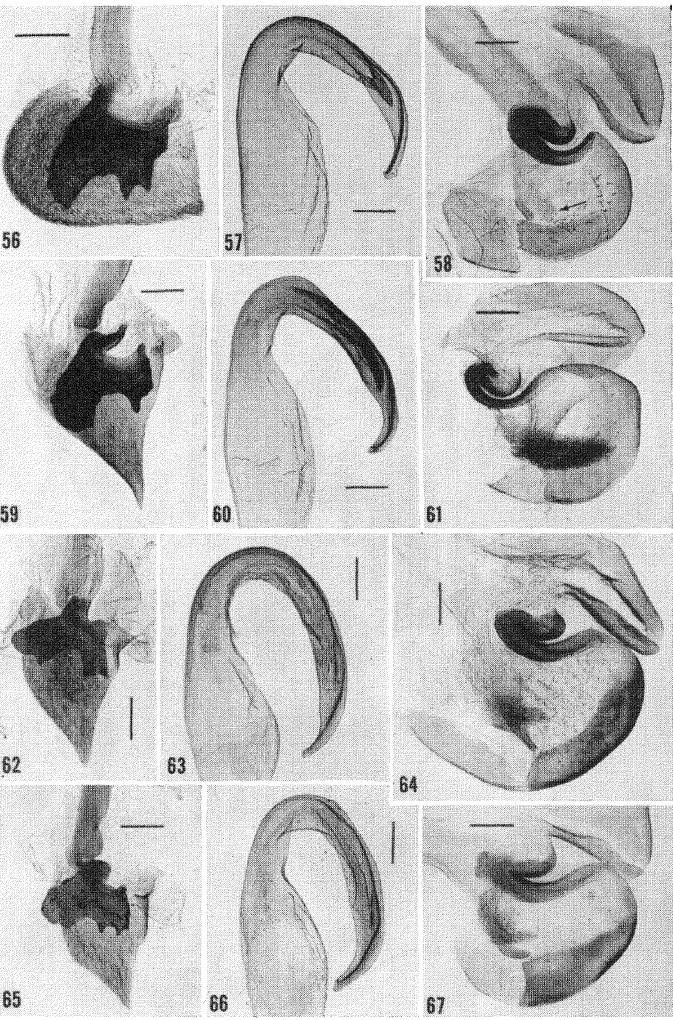
Figs. 56-67. Cockroach male genitalia. 56-58. (83 USNM). Epilampra taira. Surinam (det. Gurney) (arrow in 58 indicates setal brush). 59- 67. Epilampra sagitta. 59-61. (74 USNM). Amapi, Brazil (det. Albuquer- que; confirmed by Princis). 62-64. (182 ANSP). Type 1135. Teffe, Ama- zo.nas, Brazil. 65-67. (N). Flores, Manaus, Brazil (det. Roth). (scale 0.2